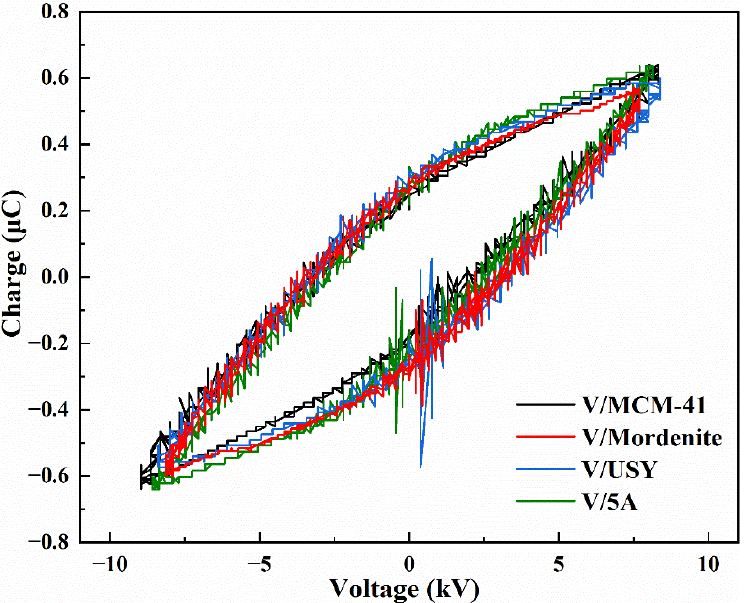
Figure 5. Lissajous figures for V/M catalyst-packed DBD reactors (Discharge power: 20 W, gas flow rate: 500 mL ∙ min − 1 and reaction temperature: 25 °C).